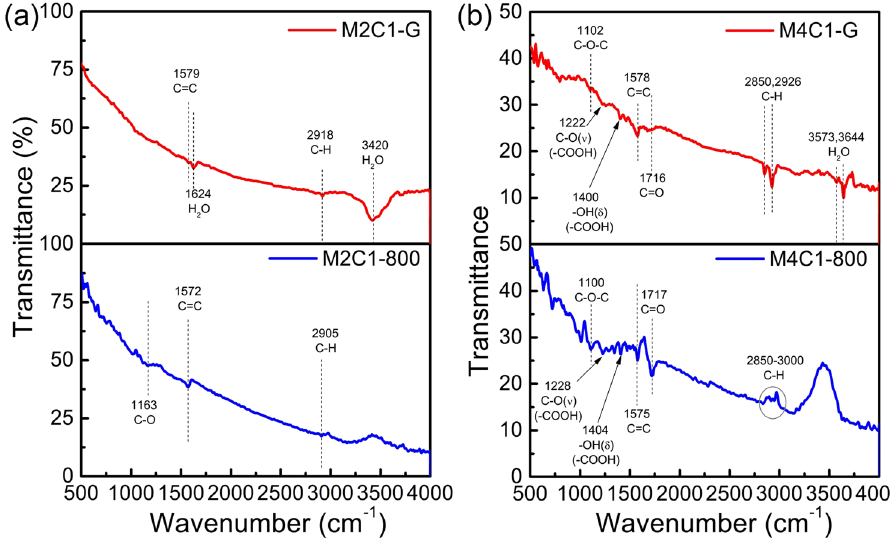
Figure 2. FTIR spectra of M2C1 ( a ) and M4C1 ( b ) at the heat treated temperature of 300 K and 800